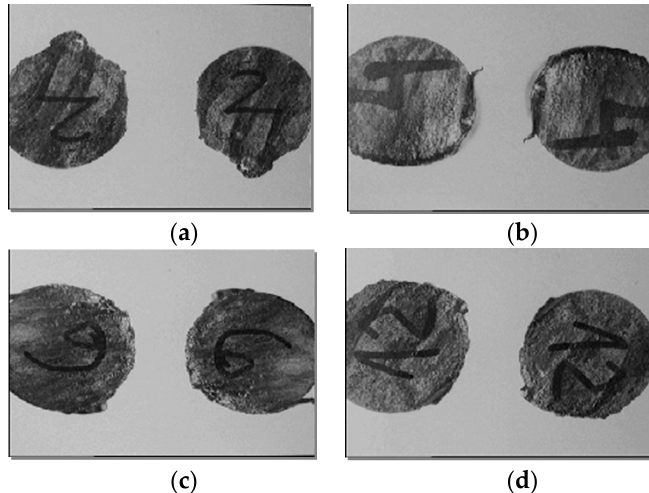
Figure 10. Dependence TIZ on the feed rate v a of PO and on the thickness of the metal band ( s ): ( a ) Sample 1, ( b ) Sample 2, ( c ) Sample 3, ( d ) Sample 4.